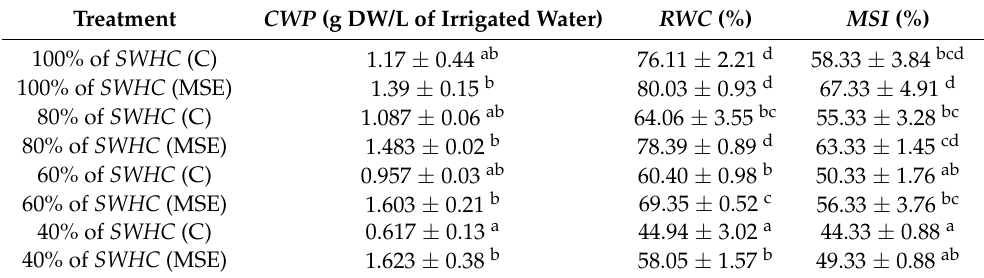
Table 4. Crop water productivity ( CWP ) and plant water status of S. frutescens plants treated with M. oleifera seed extract (MSE) under deficit irrigation conditions.